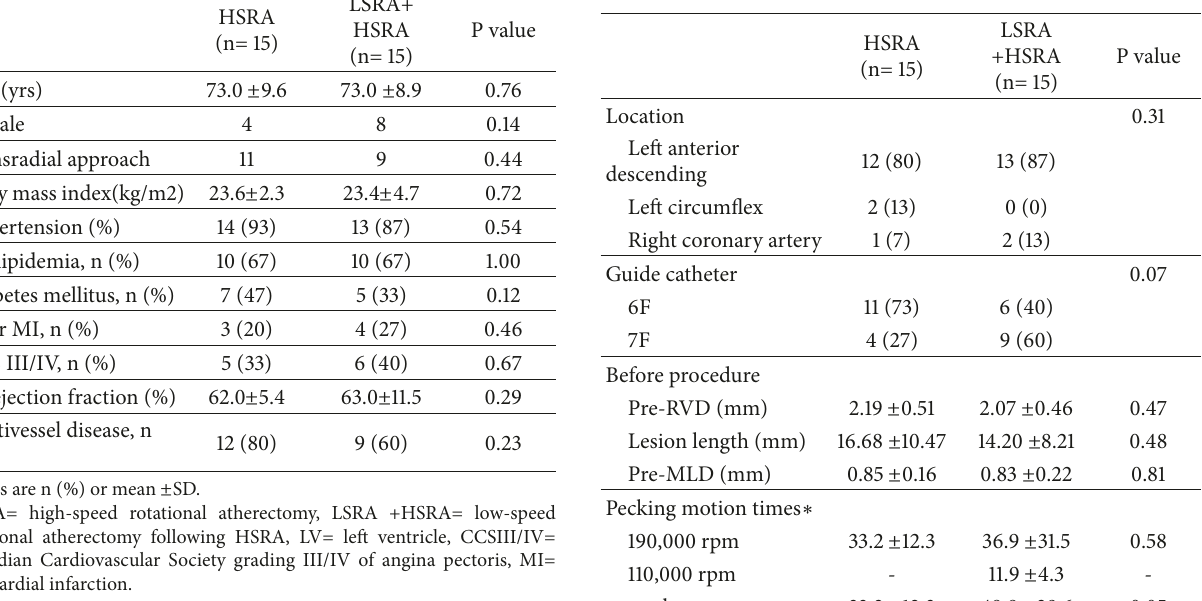
Table 3: Angiographic and procedural characteristics (QCA) (n= 30 lesions).